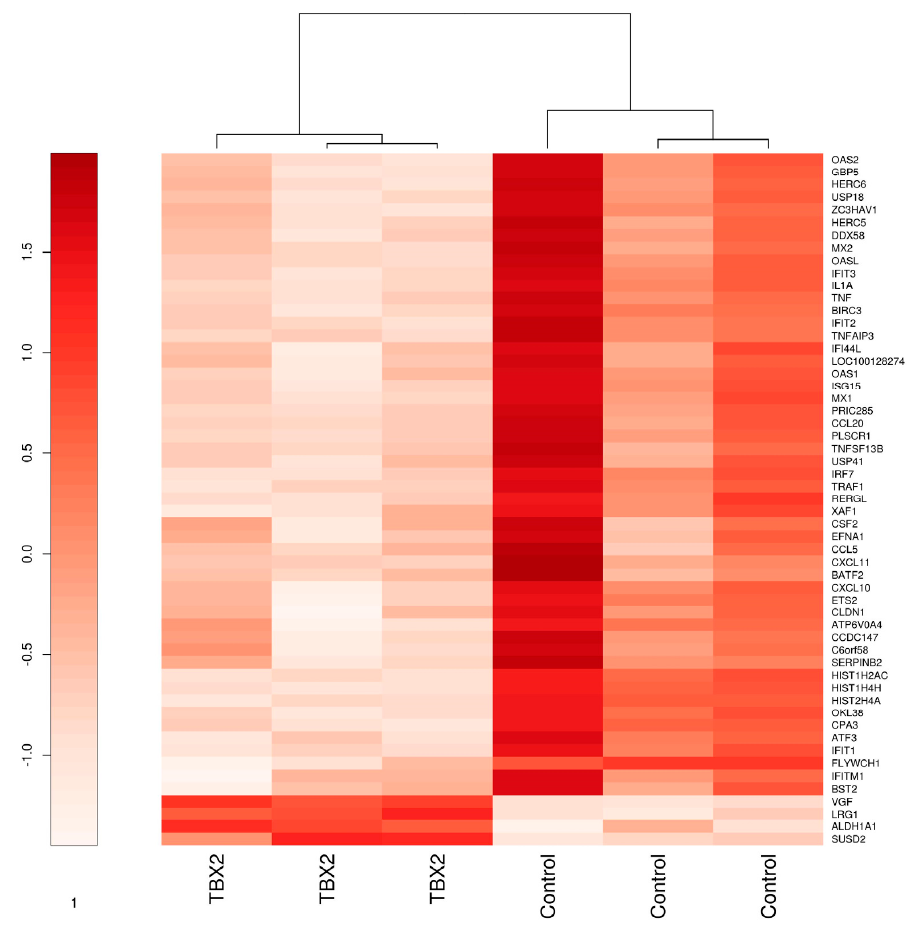
Figure 1. Heatmap of Differentially expressed genes in hTERT-HM cells overexpressing TBX2. Differentially expressed ( n = 55) genes with a log2 fold change >1.5 ( p value < 0.1) in TBX2 overexpressing hTERT-HM myometrial cells vs. EGFP transduced control cells. Genes are hierarchically clustered using the ward.D algorithm.